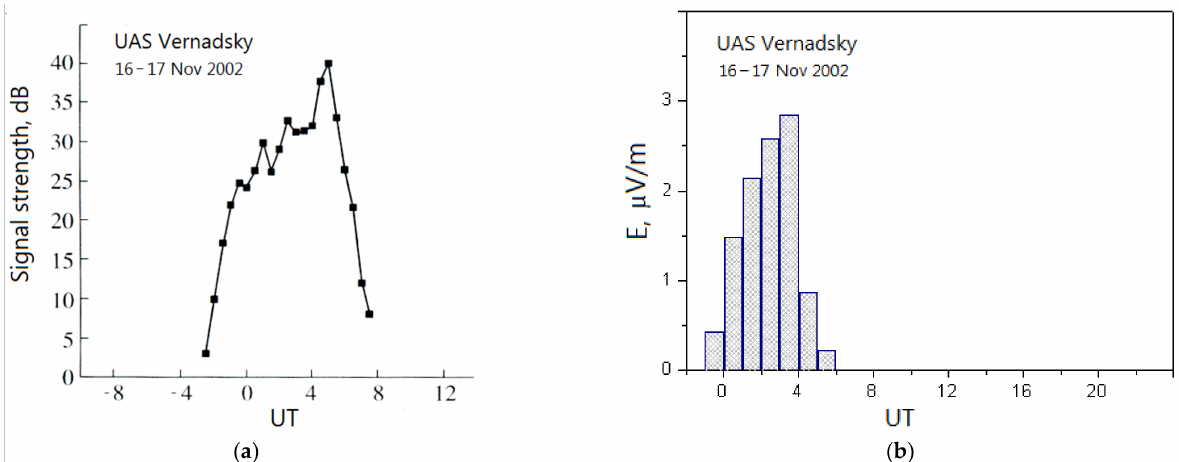
Figure 7. Time dependence of the measured radio signals level ( a ) and calculated values of the field strength in the IRI model ( b ) on the 4996 kHz frequency from the Moscow (RWM) station. The time interval of a radio waves passage is characterized by overall nocturnal conditions on the super long radio